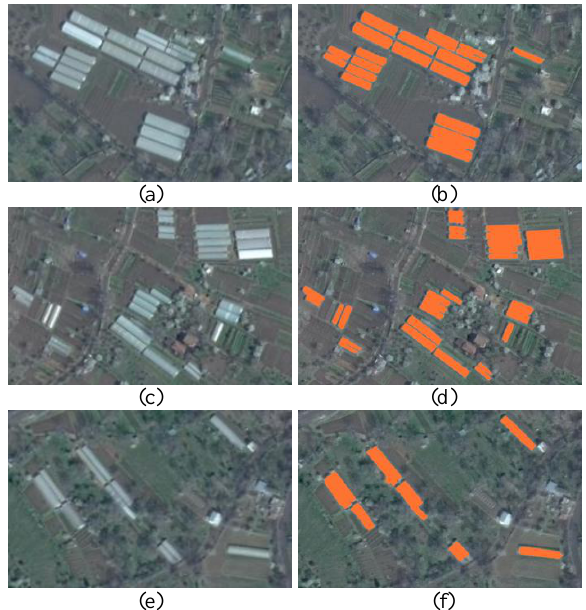
Figure 1. Extraction of greenhouses for three different regions. (a) (c) (e) Input image, (b) (d) (e) Output extracted image